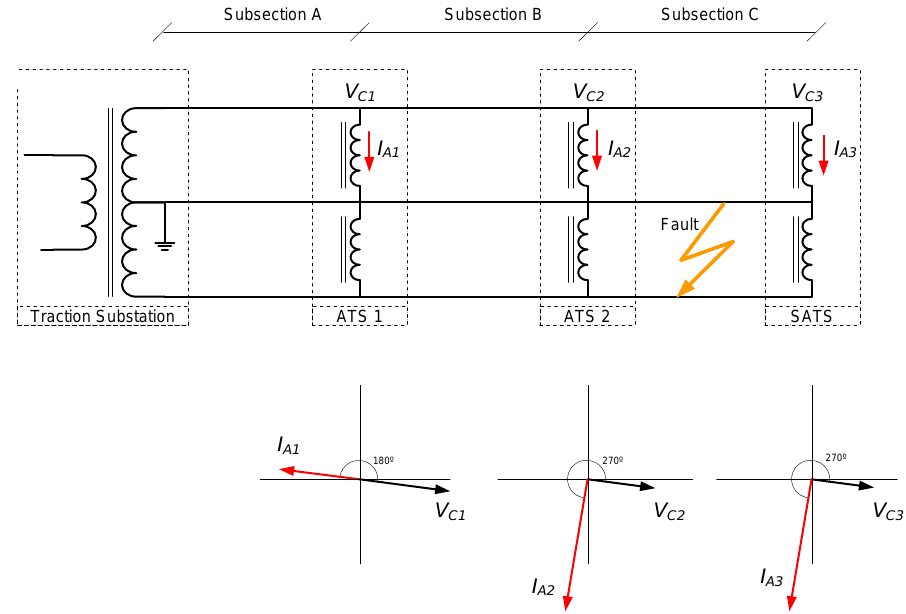
Figure 2. Angular difference between currents ( I A ) and voltages in catenary ( V C ) in autotransformers with fault between feeder and ground in subsection C.